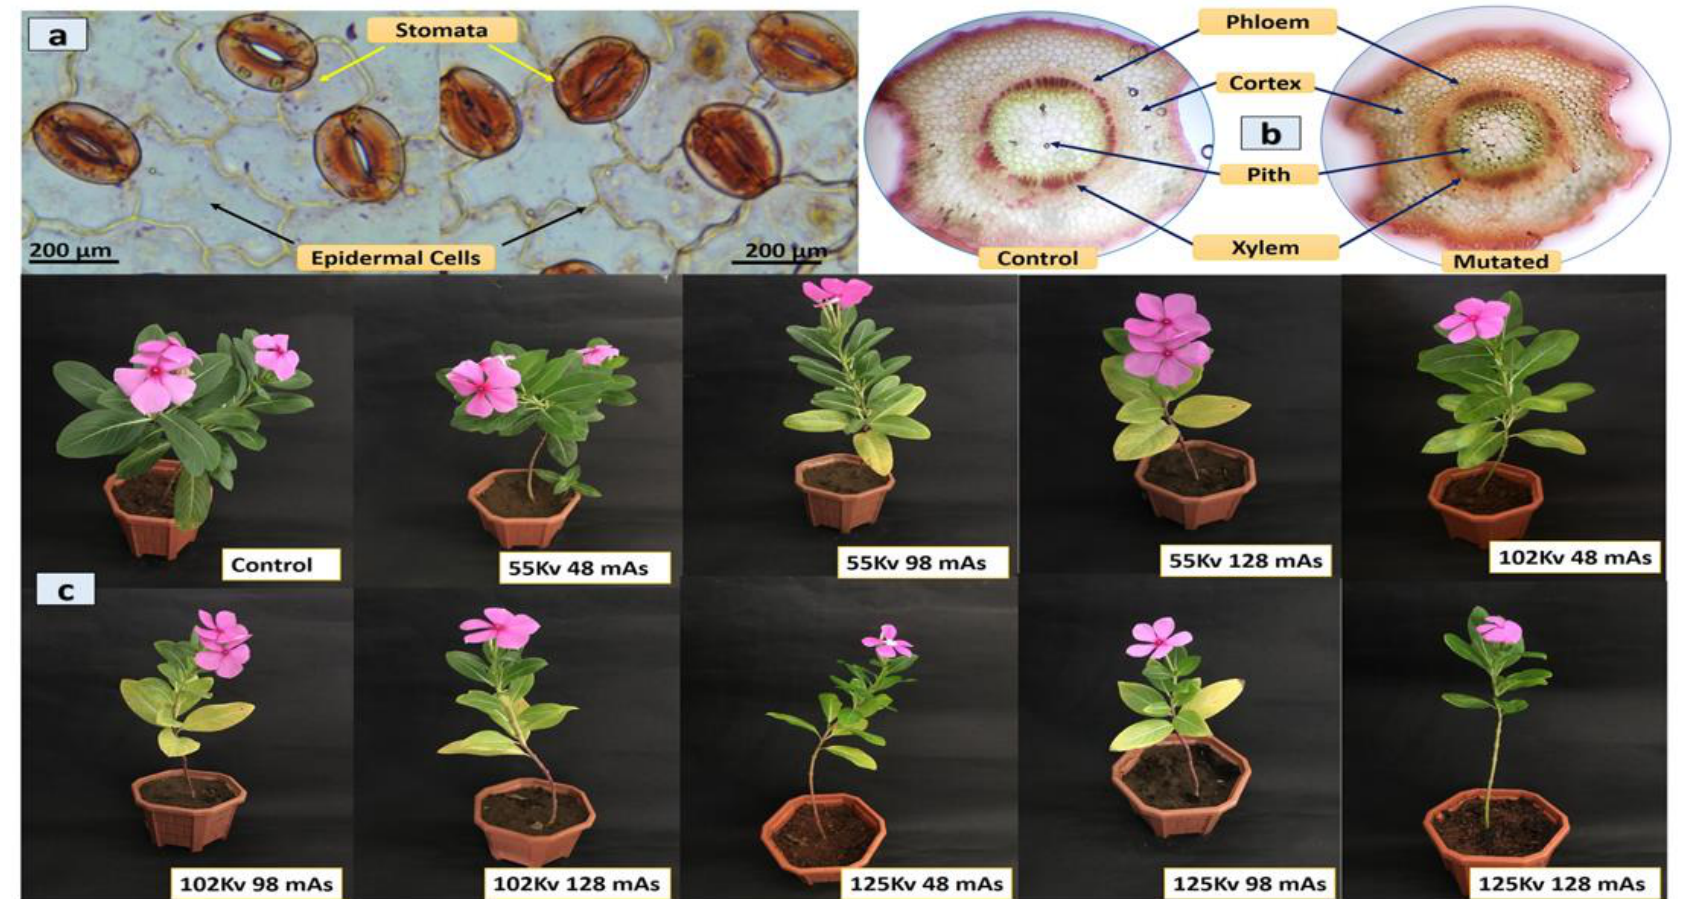
Figure 3. Microscopic and morphological observations of mutated and control C. roseus plants. The figures are represented as follows: ( a ) The thick-walled epidermis cell was irregularly organized and the stomatal assemblies with both anomocytic and anisocytic stomata were seen embedded in amoeboid epidermal cells. ( b ) The vascular bundle was encircled with endodermis in both mutated and control plants, with phloem having thin-walled fiber cells. The pith was comprised of isodiametrical parenchyma and idioblast cells, including a major portion of the stem. ( c ) The physical mutagenesis by X-rays affected the plant growth and morphology.